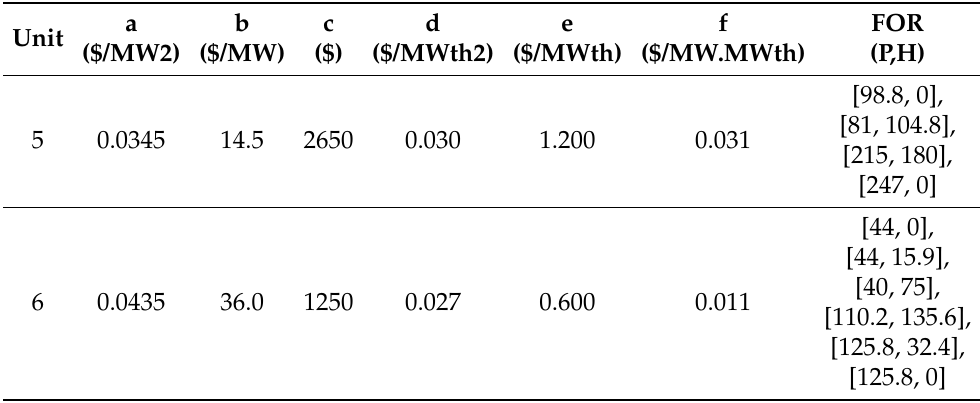
Table A8. Cogeneration unit data for Case Study 3.